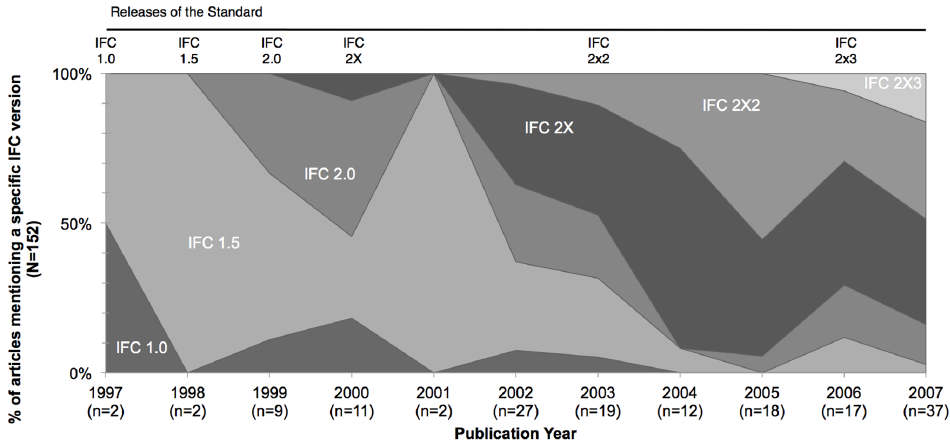
Figure 3. Publication year contrasted with version of IFC standard mentioned or applied in the article.